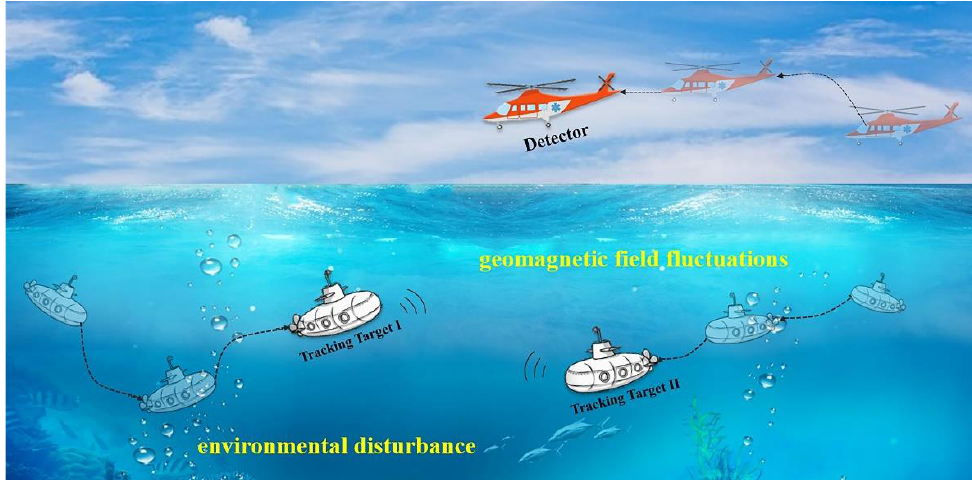
Figure 1. Schematic diagram.